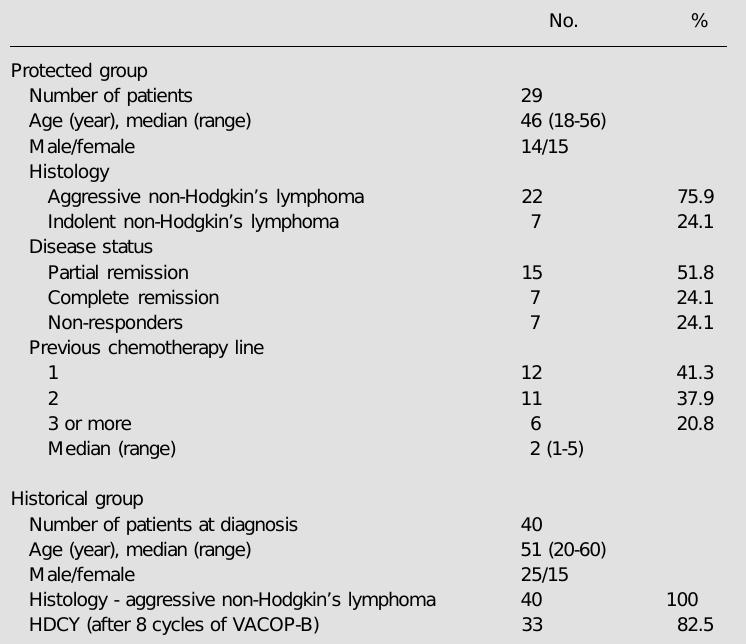
Table 2 - Characteristics of the patients studied. HDCY, High-dose